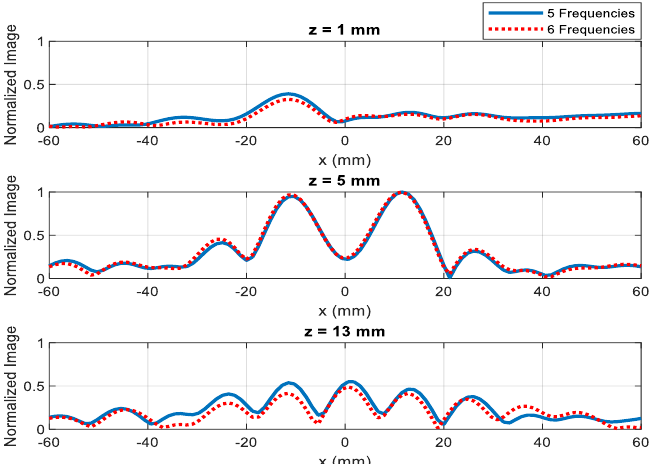
Figure 15. Reconstructed 1D images for copper strips placed at a depth of 5 mm when using data at 5 and 6 resonant frequencies.